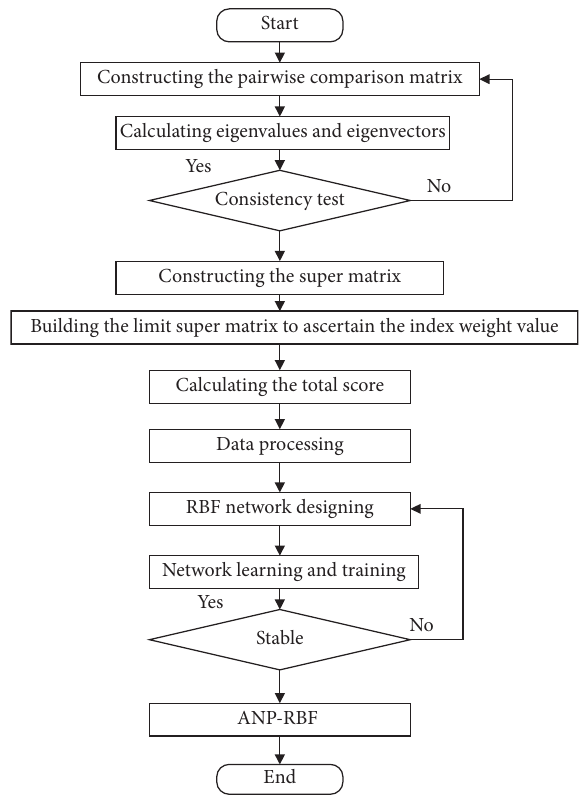
Figure 2: Building process of the ANP-RFB neural network model.